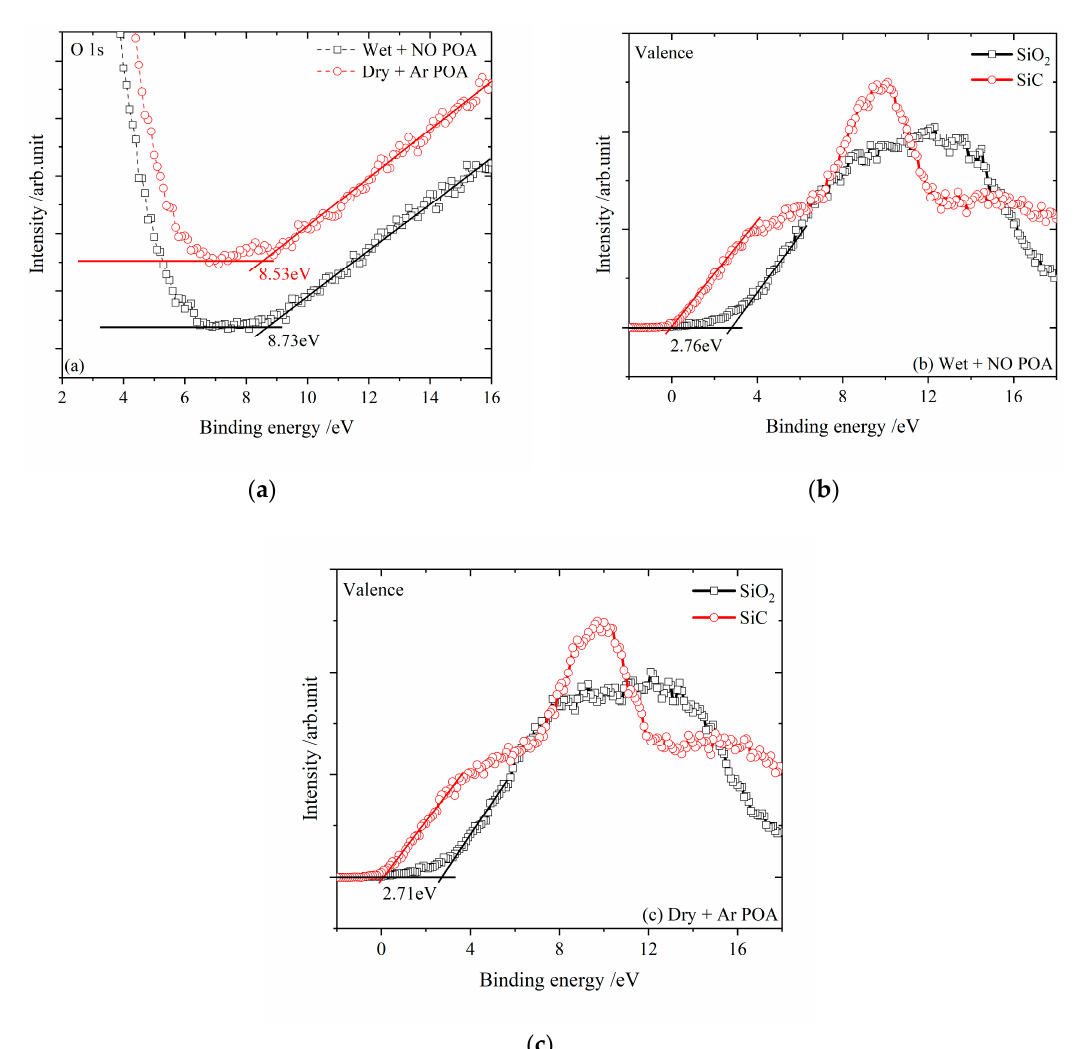
Figure 5. ( a ) O 1s energy loss spectra for both the samples Valence band spectra for the ( b ) H&N hybrid and ( c ) Ar passivation samples.